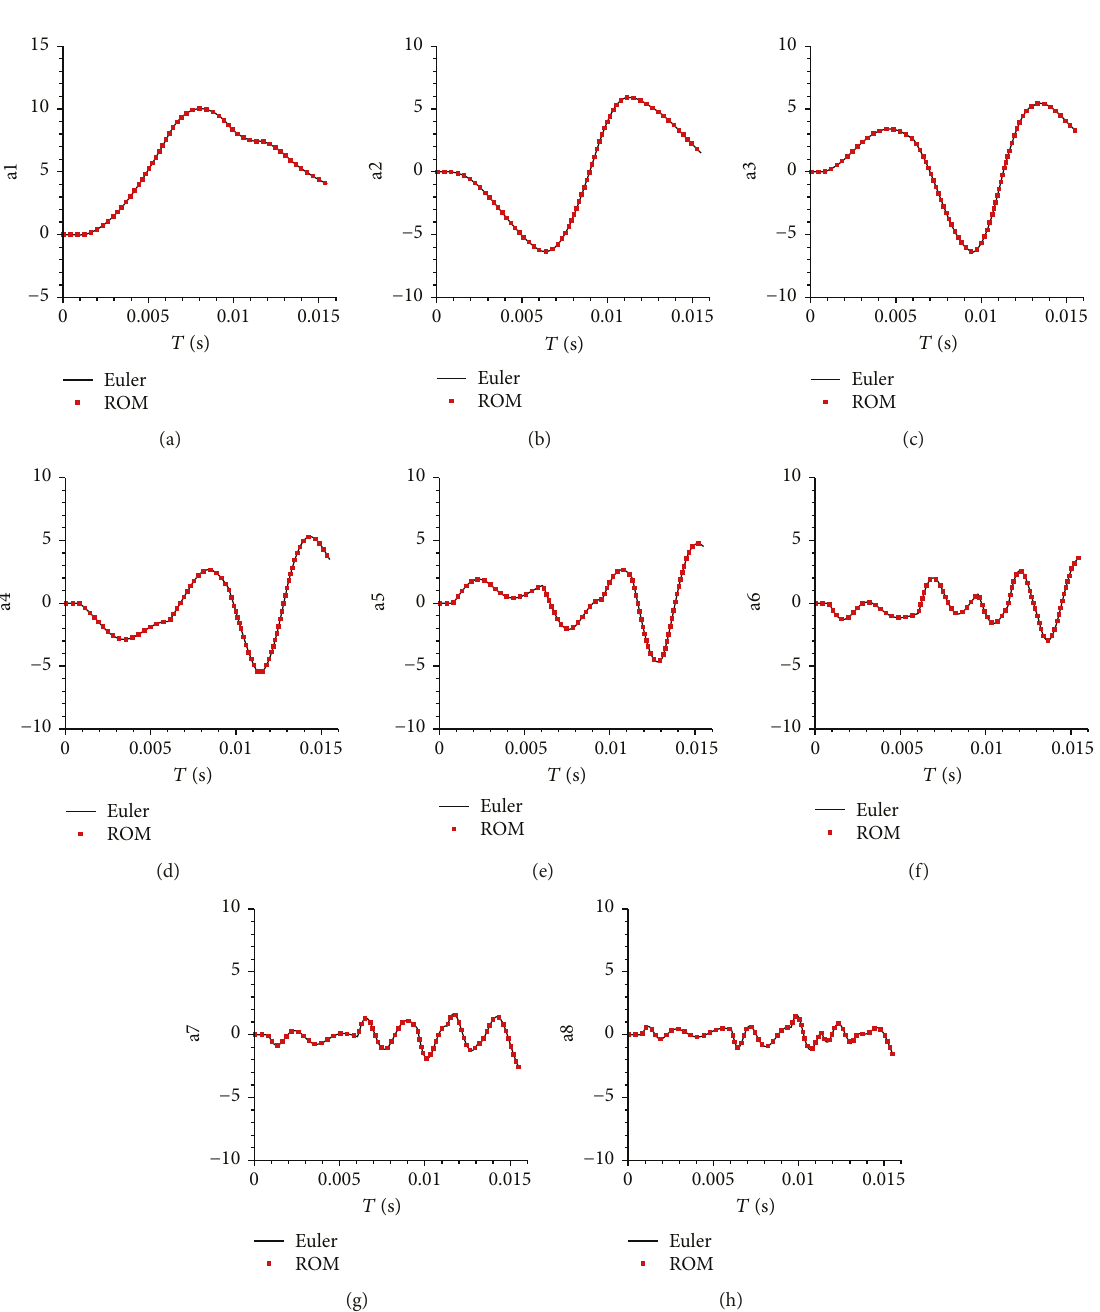
Figure 4: Comparison of modal coe ffi cients obtained from Euler and ROM solution to “ 3211 ”